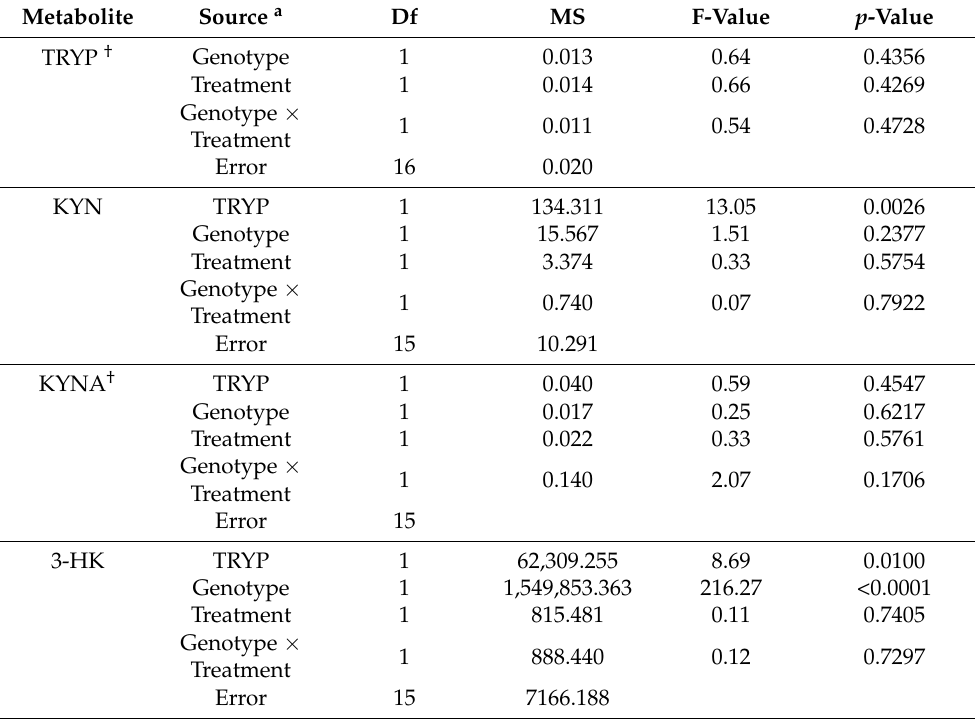
Table 1. Analysis of Covariance for kynurenine pathway metabolites in the heads of AD and control flies. Metabolite